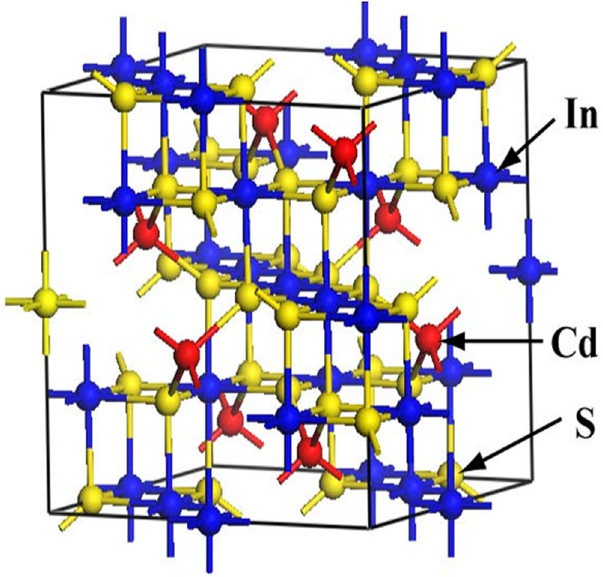
Figure 1. The conventional unit cell of CdIn 2 S 4 . (The Cd atom is denoted by the red sphere, In atom by the blue sphere, and S atom by the yellow